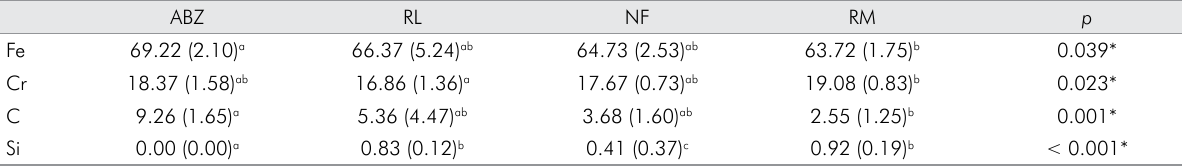
Table 1. Means and standard deviation for percentages of Iron (Fe), Chrome (Cr), Carbon (C) and Silicon (Si), according to the bracket group